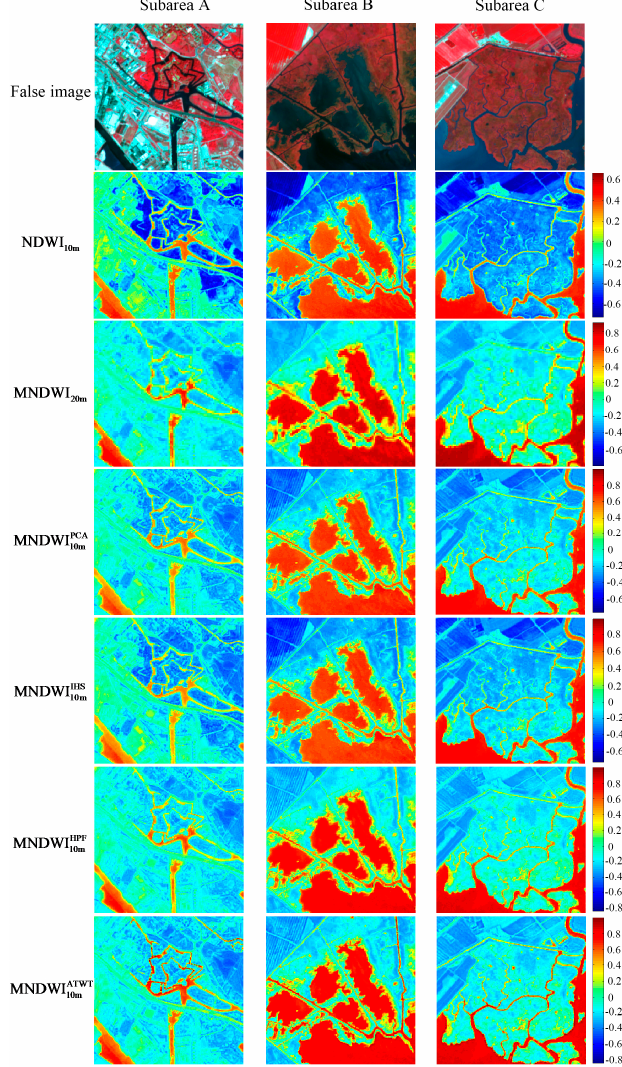
Figure 4. Subarea of the 10-m false colour maps, NDWI and MNDWI images shown in Figures 1 and 2. The first column is for Subarea A; the second column is for Subarea B; and the third column is for Subarea C.